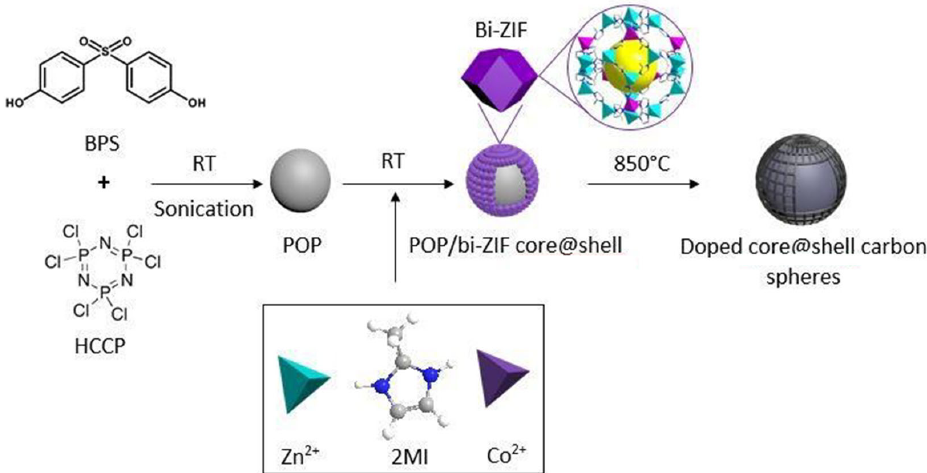
Figure 10. Schematic display of the synthesis along with carbonization of POP/bi–ZIFcore@shell structures. Taken with permission from [133].